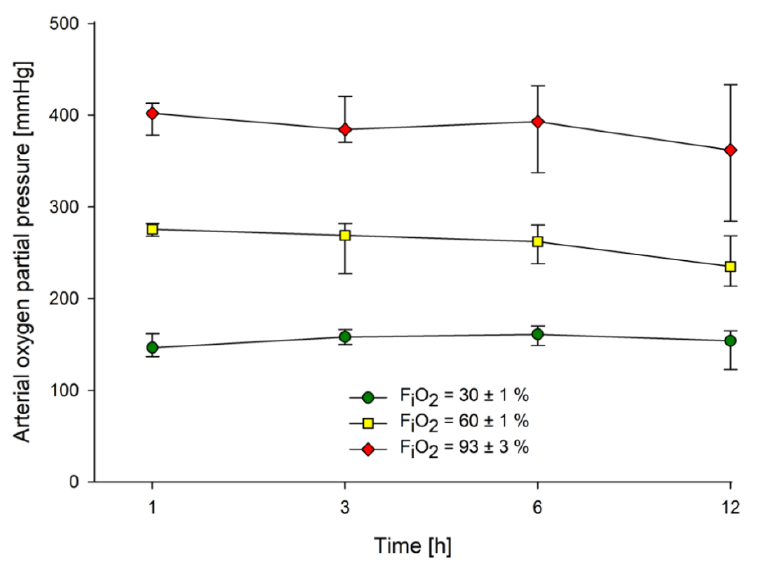
Figure 1. Arterial oxygen partial pressure. Data presented as medians and interquartile ranges. F i O 2 = fraction of inspired oxygen.